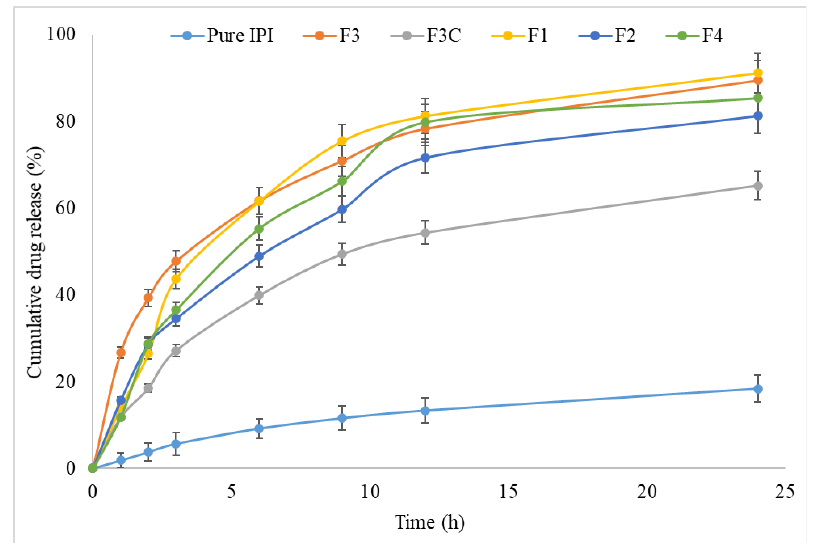
Figure 2. In vitro drug release profile of IPI vesicles (F1, F2, F3, F4) and IPI chitosan vesicle (F3C). Study performed in triplicate and data shown as mean ± SD.